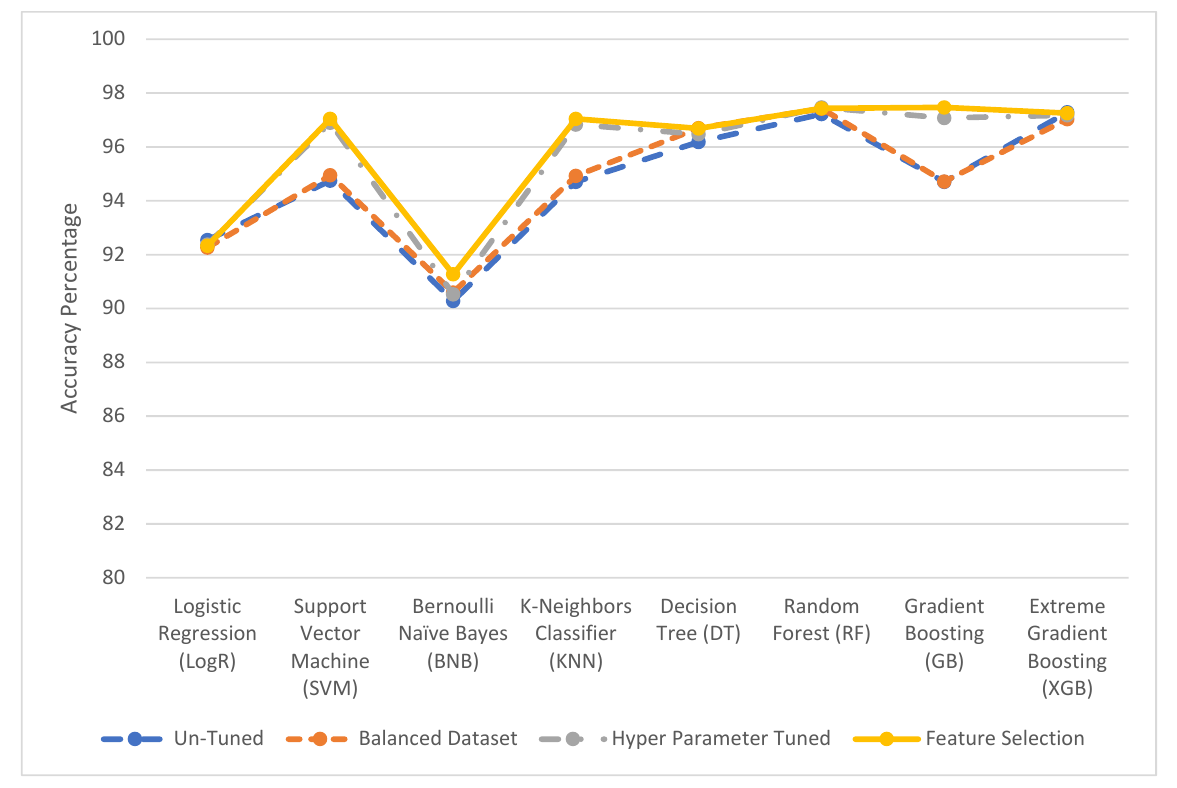
Figure 8. Dataset-1 performance (accuracy %) comparison. Table 17. Dataset-2 performance (accuracy %) comparison.